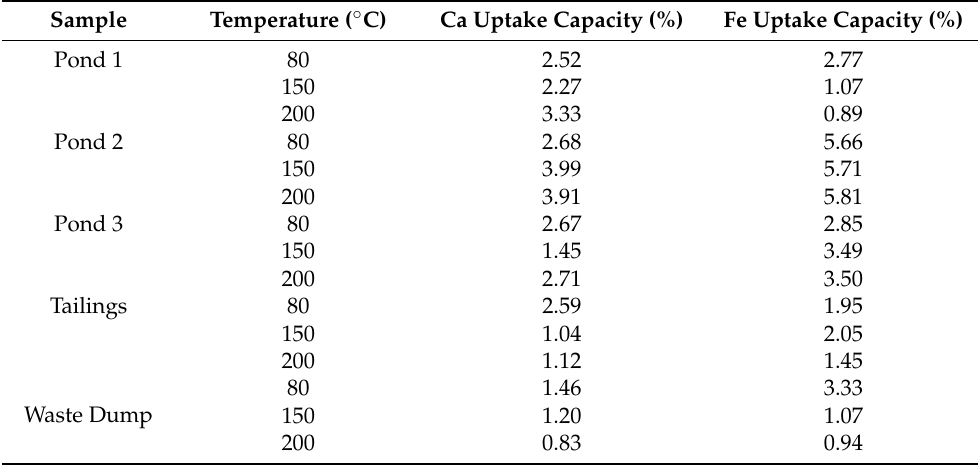
Table 1. Ca and Fe uptake capacity (%) of Fe-rich mine waste in different